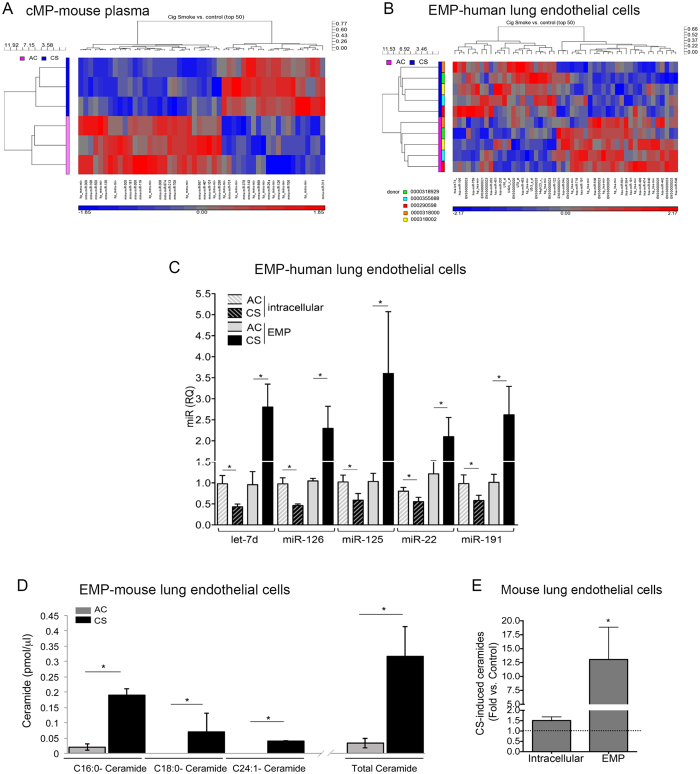
CS exposure increases specific miRNAs and ceramide species in mouse cMPs and human EMPs.(A,B) miRNA expression profiles in MPs. Heatmaps of top 50 individual differentially expressed miRNAs (Increased=red; decreased = blue) detected in cMPs from plasma of AC (pink, n = 3) or CS (3 d; blue, n = 3)-exposed mice (F); or in EMPs from AC (pink; n = 5) or CS (2%, 2 h; blue, n = 5)-exposed HLMVEC isolated from five donors. (C) miRNAs levels measured by RT-PCR intracellular and in EMPs from AC- and CS-exposed HLMVEC (Mean+SEM, n = 4, ANOVA p < 0.05; Sidak’s *p < 0.05). (D) The most abundant ceramide species and total ceramide levels in EMP released from MLEC cells treated with CS (10%; 24 h) or AC control. Levels measured by mass spectrometry, normalized by volume of supernatant used to isolate EMP). Mean ± SEM; Student’s t-test *p < 0.05, n =  3. (E) Relative change in ceramide (vs. AC; dotted line) in intracellular- compared to EMPs compartments in CS (10%; 24 h)-exposed MLEC. Mean+SEM (t-test *p < 0.05, n =  3).